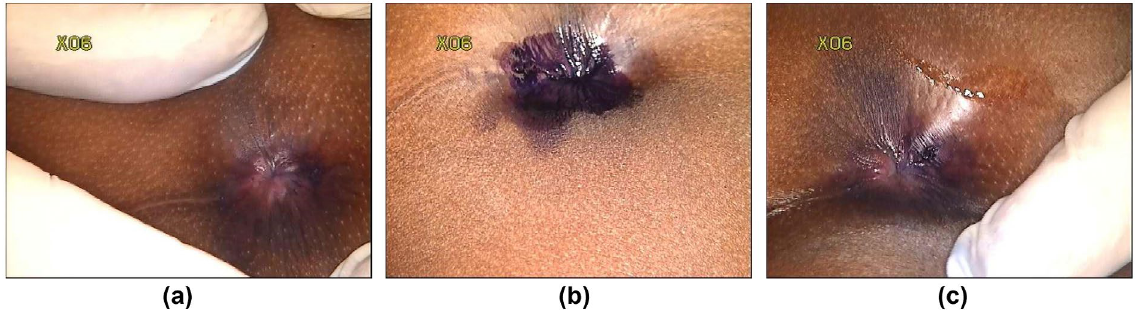
Figure 1. Three photos of a boy, (a) before toluidine blue application, (b) after toluidine blue application and (c) with the tear visible after removal of toluidine